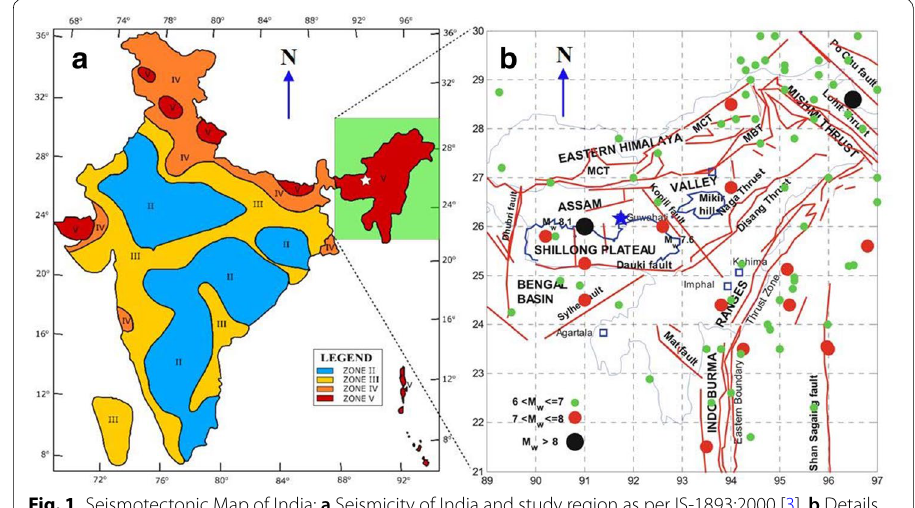
Fig. 1 Seismotectonic Map of India: a Seismicity of India and study region as per IS-1893:2000 [3]. b Details of seismic fault nearby the study region [7]